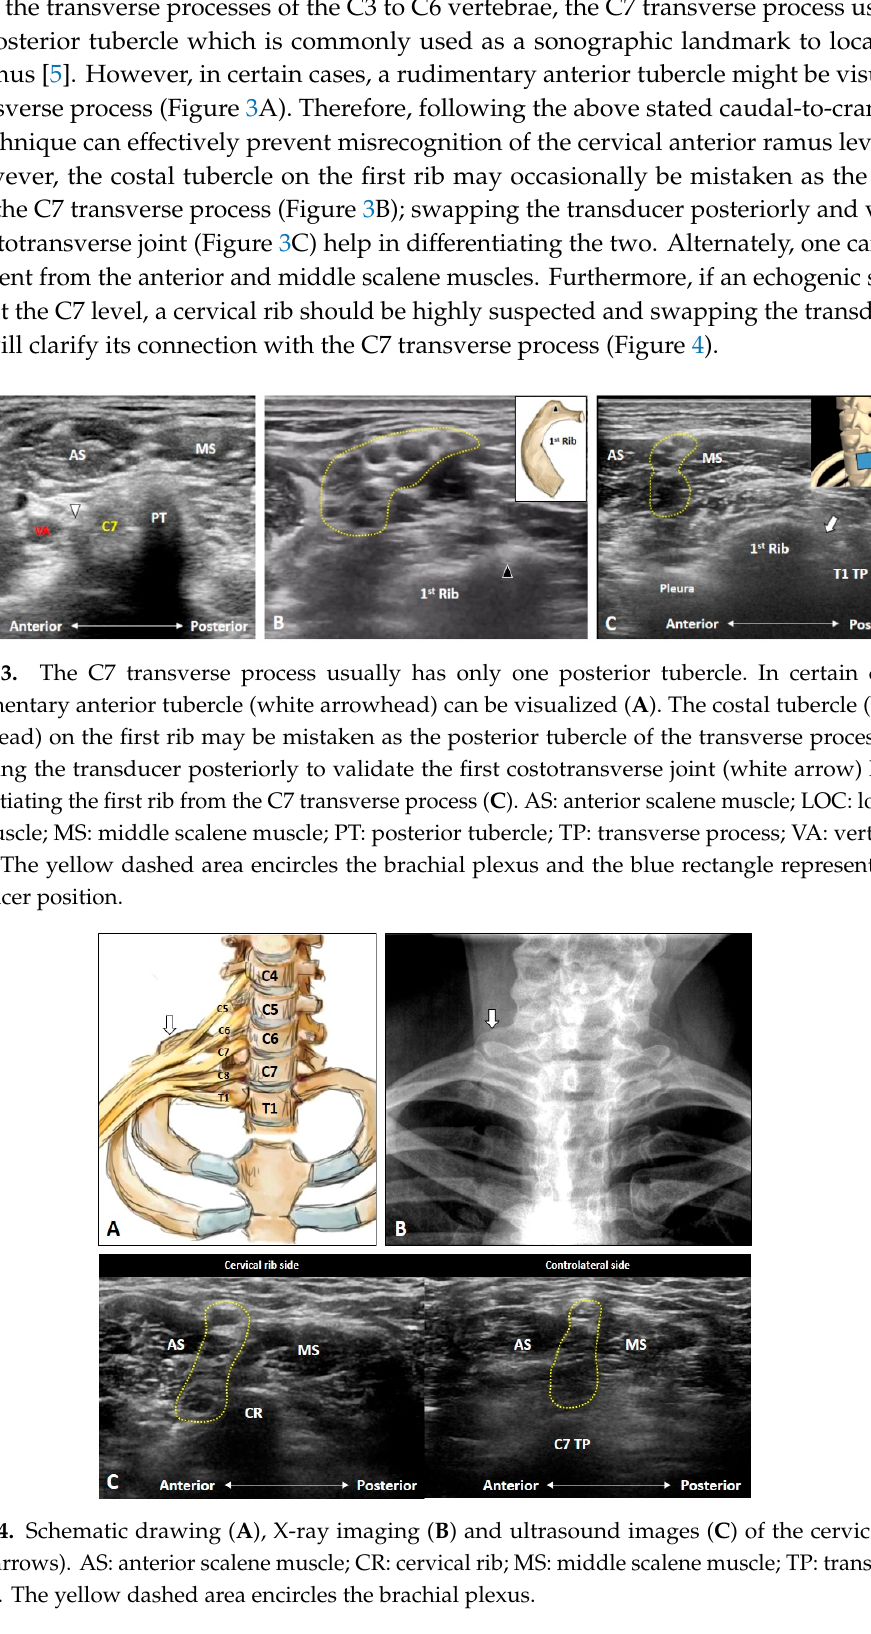
Figure 4. Schematic drawing ( A ), X-ray imaging ( B ) and ultrasound images ( C ) of the cervical rib (white arrows). AS: anterior scalene muscle; CR: cervical rib; MS: middle scalene muscle; TP: transverse process. The yellow dashed area encircles the brachial plexus.